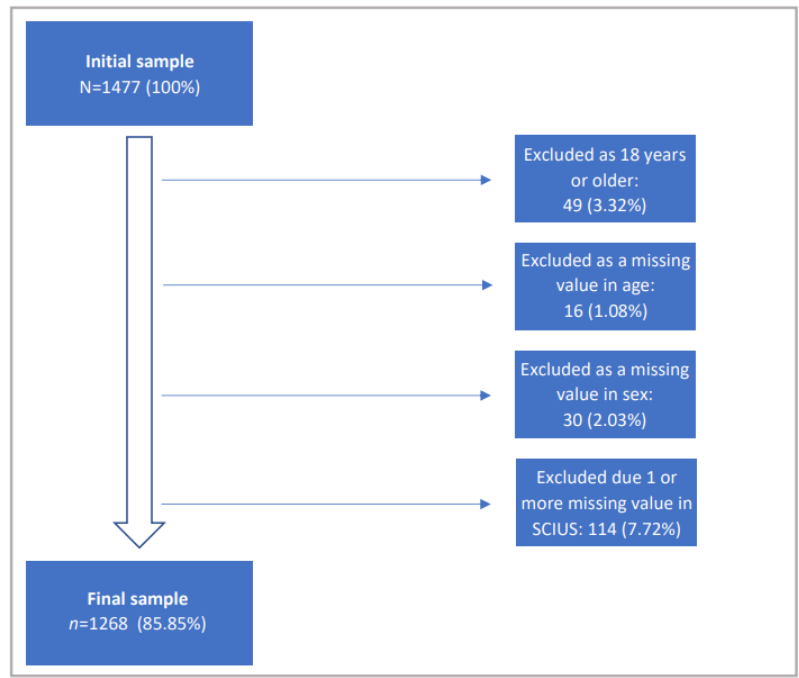
Figure 1. Flow of